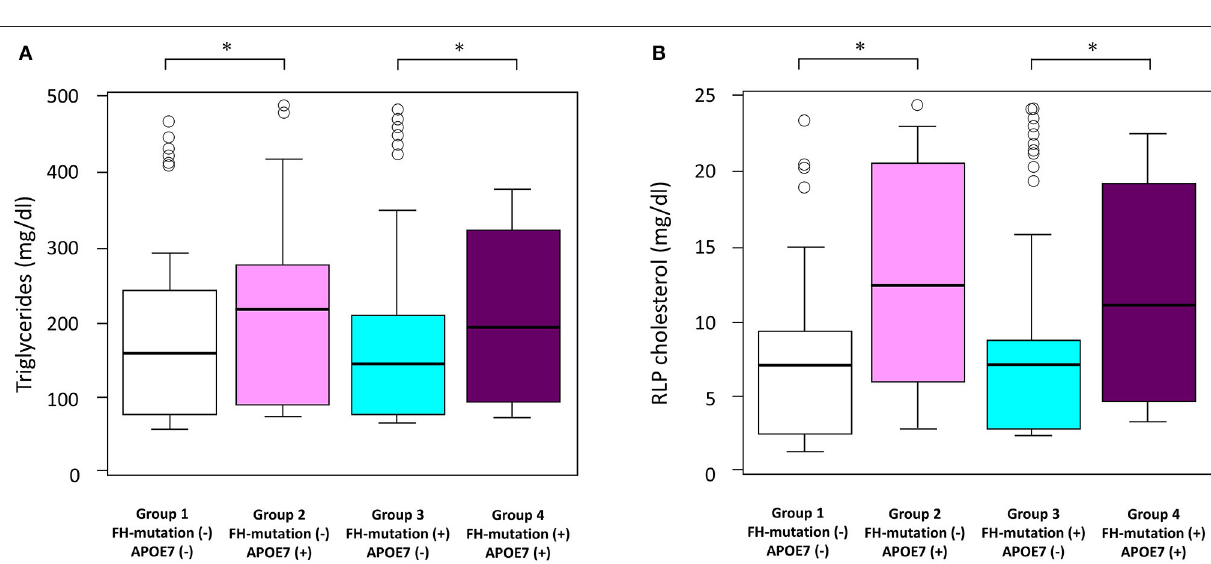
FIGURE 3 | Impact of FH gene and APOE7 on (A) triglyceride and (B) RLP cholesterol levels. Boxplots are showing triglyceride and RLP cholesterol. * p < 0.05. Analyses of variance followed by Tukey post-hoc test were used to test the differences among the